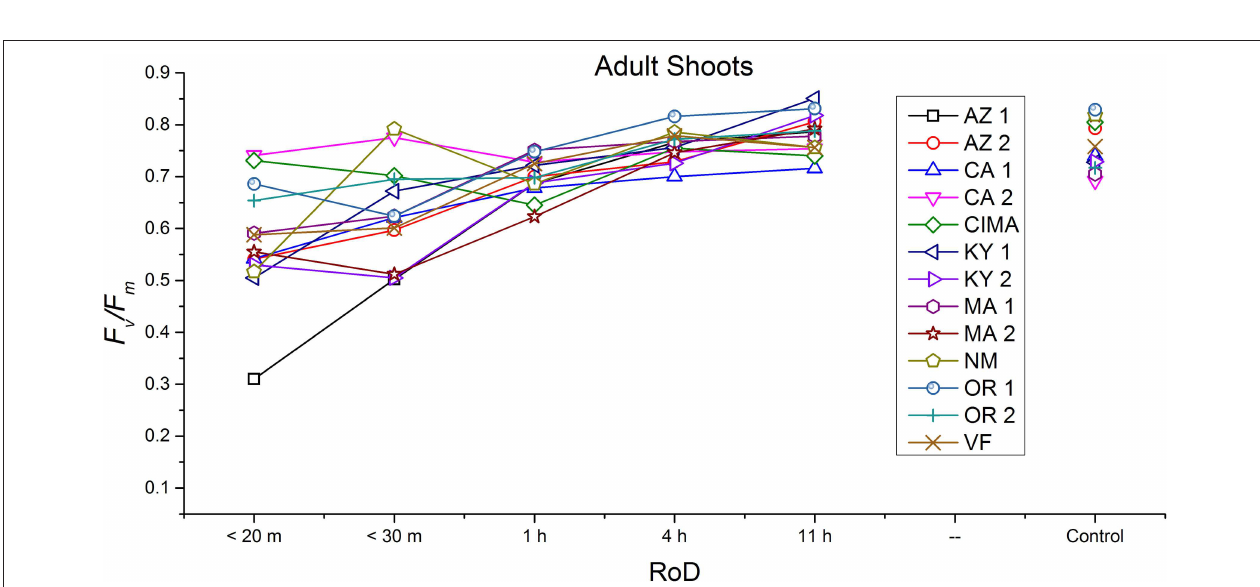
FIGURE 7 | Reaction norms for adult shoots from 13 ecotypes exposed to five rates of drying (RoD) 24h post